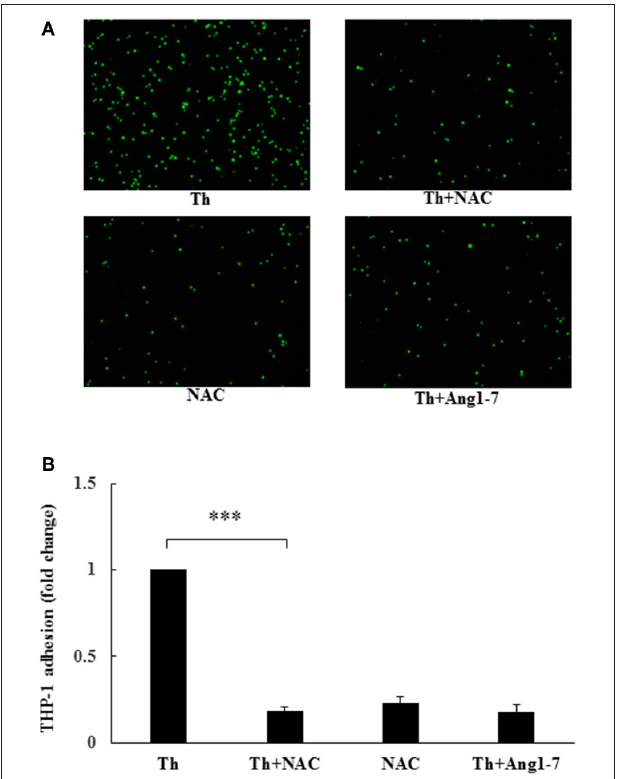
FIGURE 5 | Protective effect of angiotensin-(1-7) on thrombin-induced monocyte adhesion is ROS-dependent. HAECs were stimulated with thrombin (2 U/mL) for 5h with or without 100nM angiotensin-(1-7) pretreatment 1h before the thrombin stimulation. Cells were pretreated with the ROS scavenger NAC at a dose of 10mM for 1h before thrombin stimulation. NAC pretreatment inhibited thrombin-induced monocyte adhesion. n = 4; *** p < 0.001 for thrombin compared with thrombin + NAC.